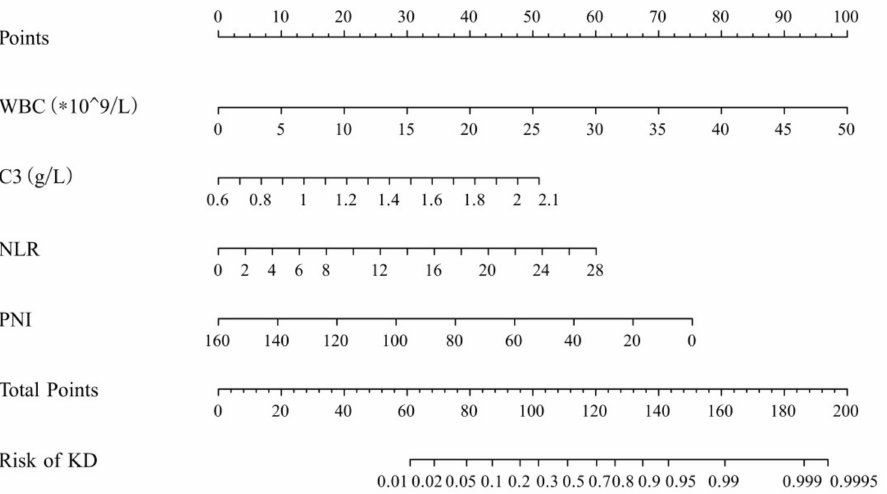
Figure 1. The nomogram for the probability of Kawasaki disease. WBC: white blood cell; C3: complement 3; NLR: neutrophil-to-lymphocyte ratio; PNI: prognostic nutritional index. KD: Kawasaki disease. Table 4. The incidence risk of Kawasaki disease corresponding with the total score. Total